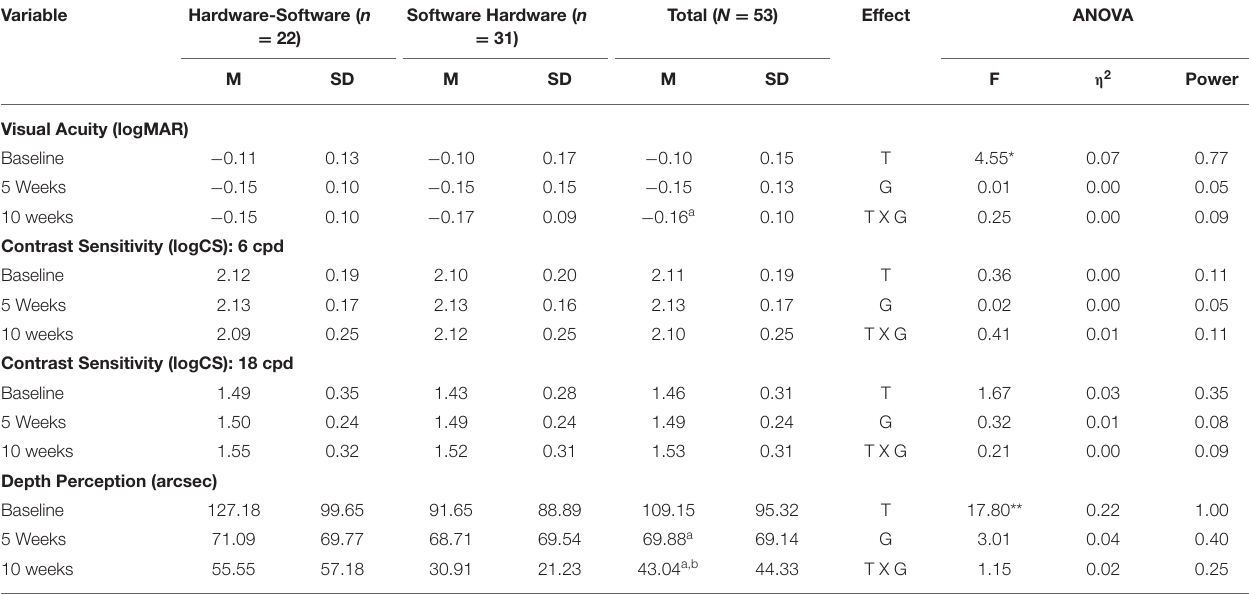
TABLE 2 | Means, Standard Deviations, and Two-way ANOVA statistics for Measures of Visual Sensitivity. Variable